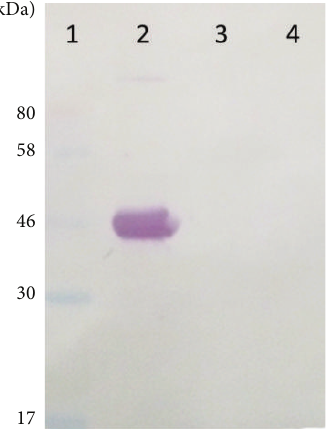
Figure 4: Western blot analysis of ST3Gal-I with 7E5 1C8 3A10 monoclonal antibodies. Lane 1: protein molecular weight marker from NEB; lane 2: purified recombinant ST3Gal-I protein (3 𝜇 g); lane 3: negative control 1 (Human Serum); lane 4: negative control 2 (recombinant galectin 3 containing 6x His tag, 31.5